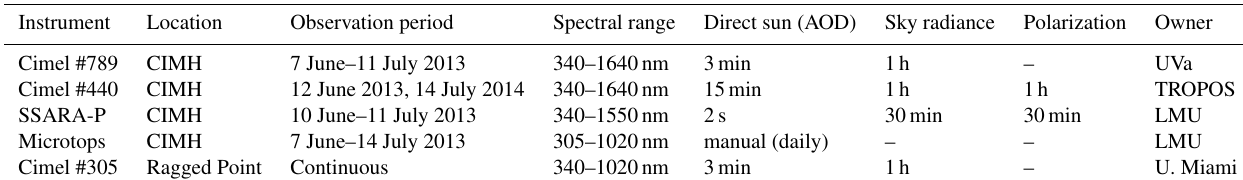
Table 1. Sun photometer instruments deployed at the CIMH and Ragged Point sites during SALTRACE. The instrument type, location, spectral range, observation period, owner and sampling interval of different measurement types are indicated. The abbreviations of the owners of these instruments refer to the University of Valladolid (UVa), the Leibniz Institute for Tropospheric Research (TROPOS), Ludwig-